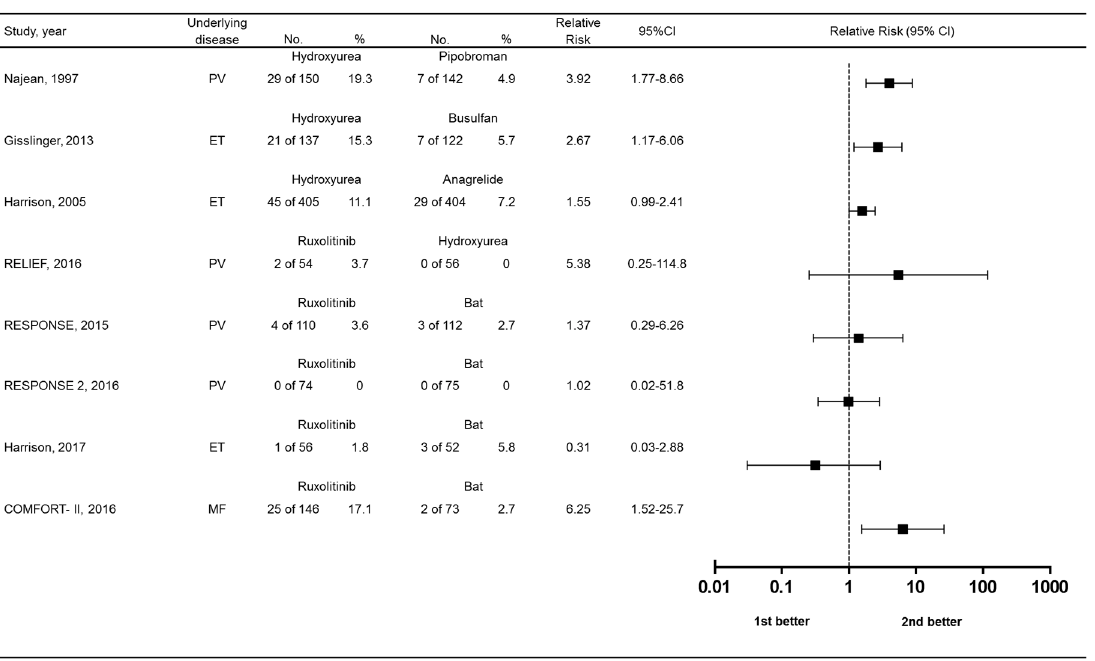
Figure 6. Forest plot showing relative risk of skin-related drug-related adverse events. Bat, best available therapy.